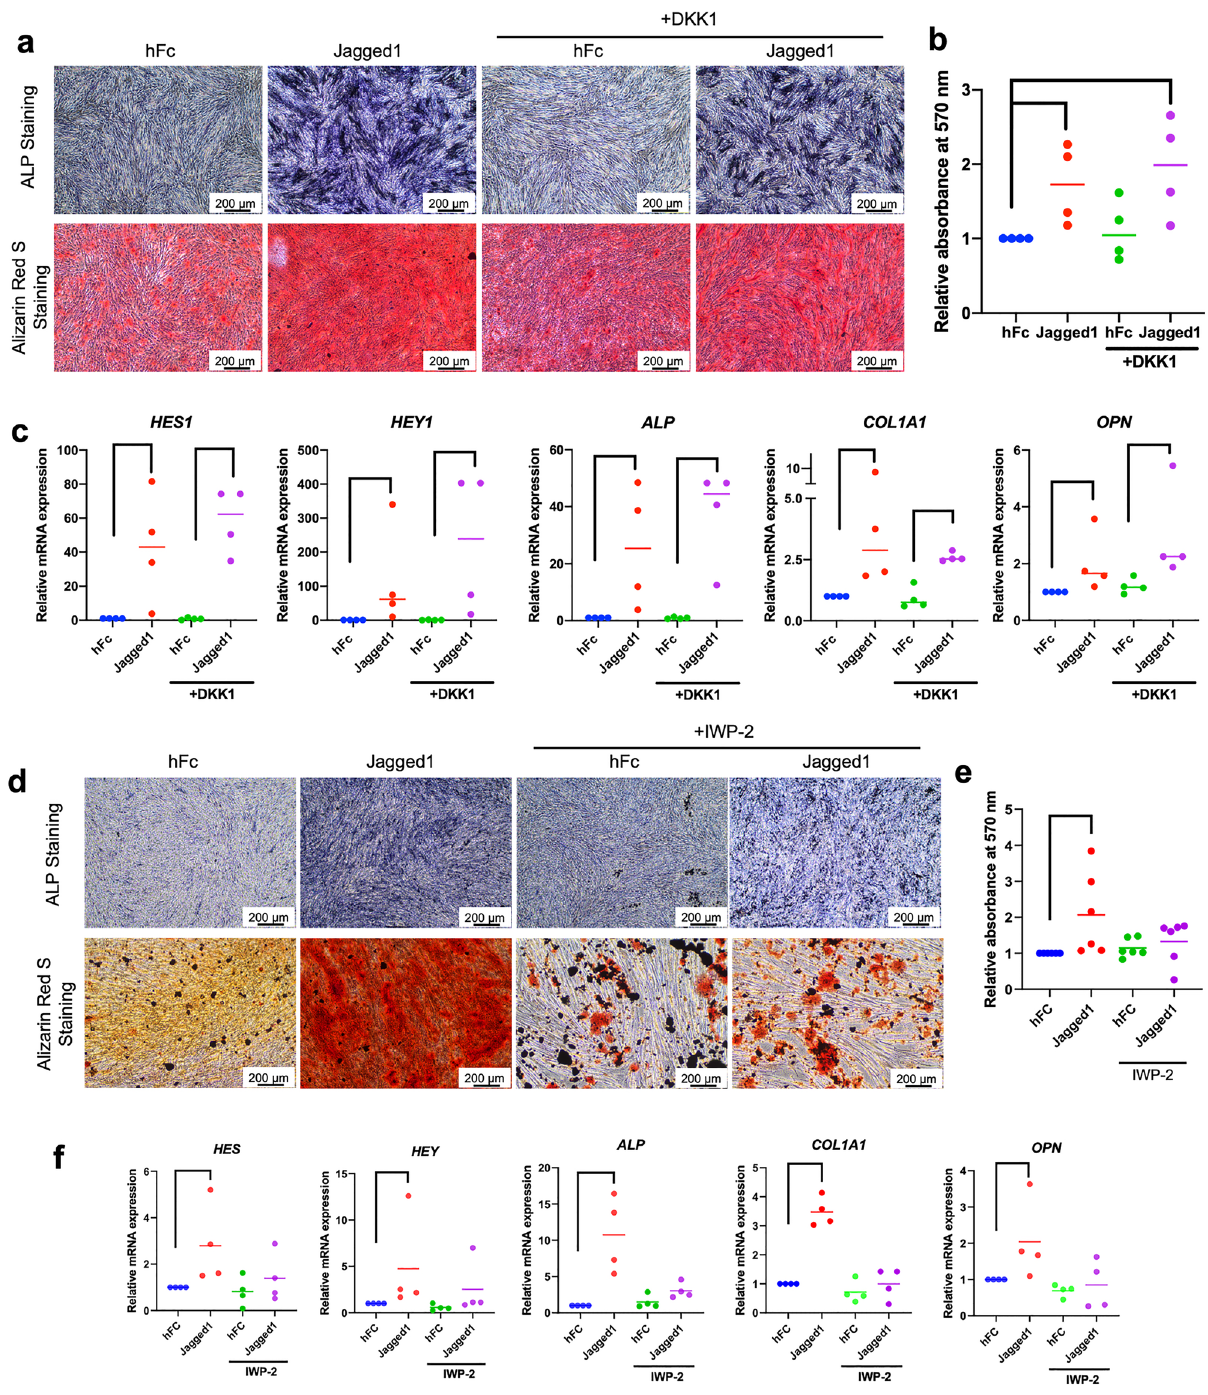
Figure 5. IWP-2 attenuates the osteo/odontogenic differentiation induced by Jagged1. Cells were pretreated with DKK1 or IWP-2 30 min prior to seeding on Jagged1 surfaces and further maintain in osteo/odontogenic induction medium. ( a and d ) ALP enzymatic activity and mineral deposition was examined at day 7 and 14, respectively. ( b and e ) The solubilized alizarin red s staining was measured and quantitated. ( c and f ) The mRNA levels of osteo/odontogenic marker genes were measured using real-time polymerase chain reaction. Bars indicate a significant difference between groups ( p <